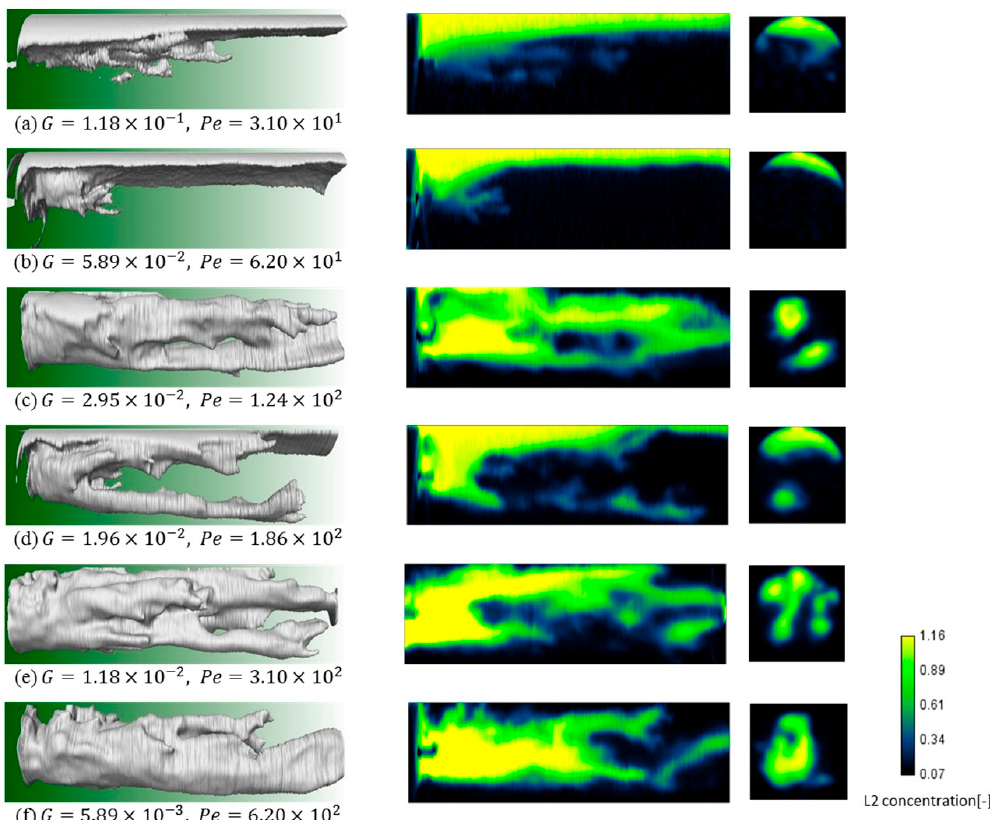
Figure 4. Left: Structure of fingering patterns at the LVF injection of 0.3 pore volume (PV) with density difference. Iso-contour surfaces corresponding to a 20 vol.% concentration of LVF are visible. Center: Concentration of LVF in a vertical cross-section through the axis of the cylinder. Right: Concentration of LVF in a vertical cross-section at the center between the inlet and the outlet.